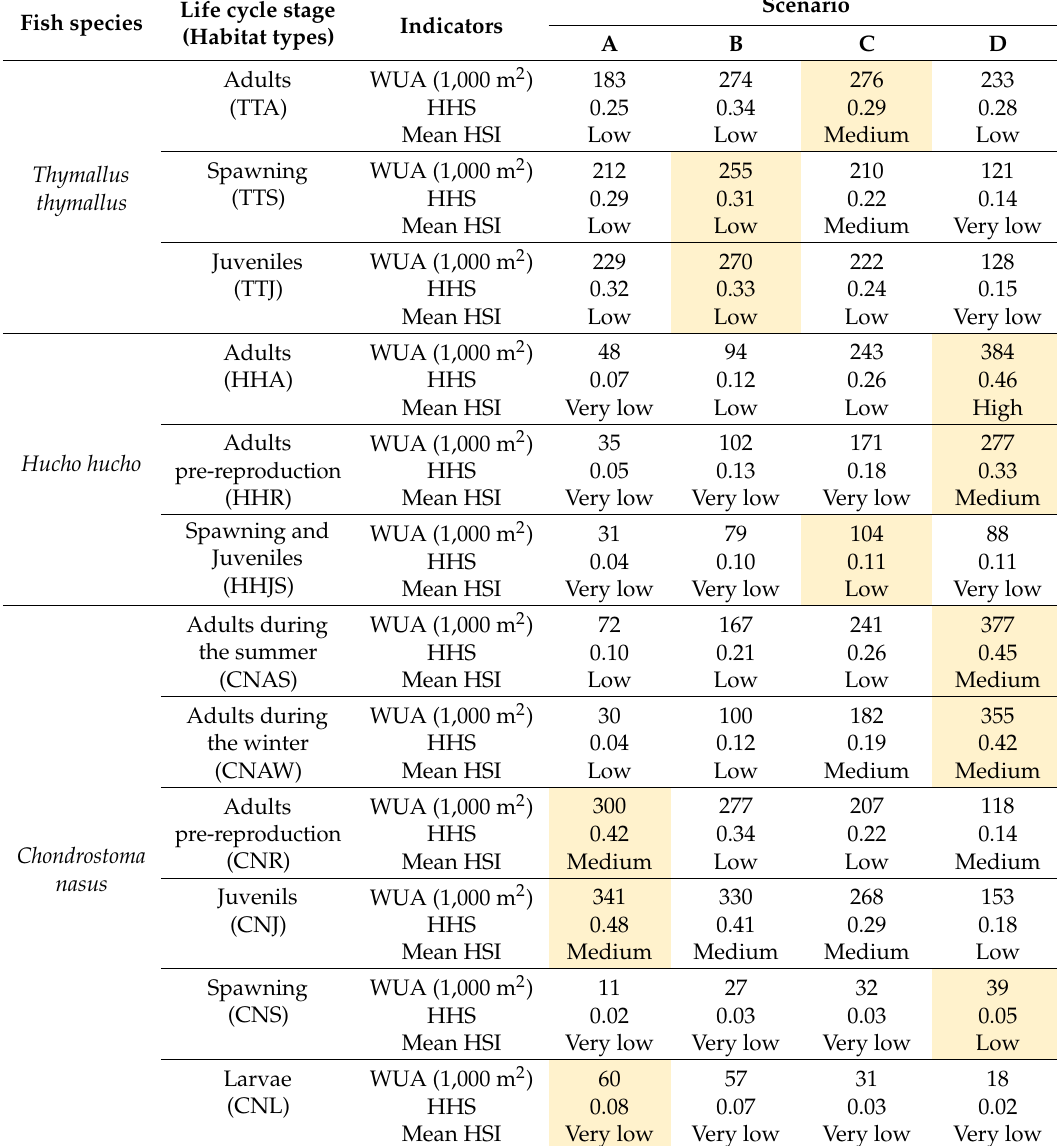
Table 4. Weighted Usable Area (WUA), Hydraulic Habitat Suitability index (HHS), and Mean Habitat Suitability Index (mean HSI) value for each habitat and scenario. The best scenario for each habitat is